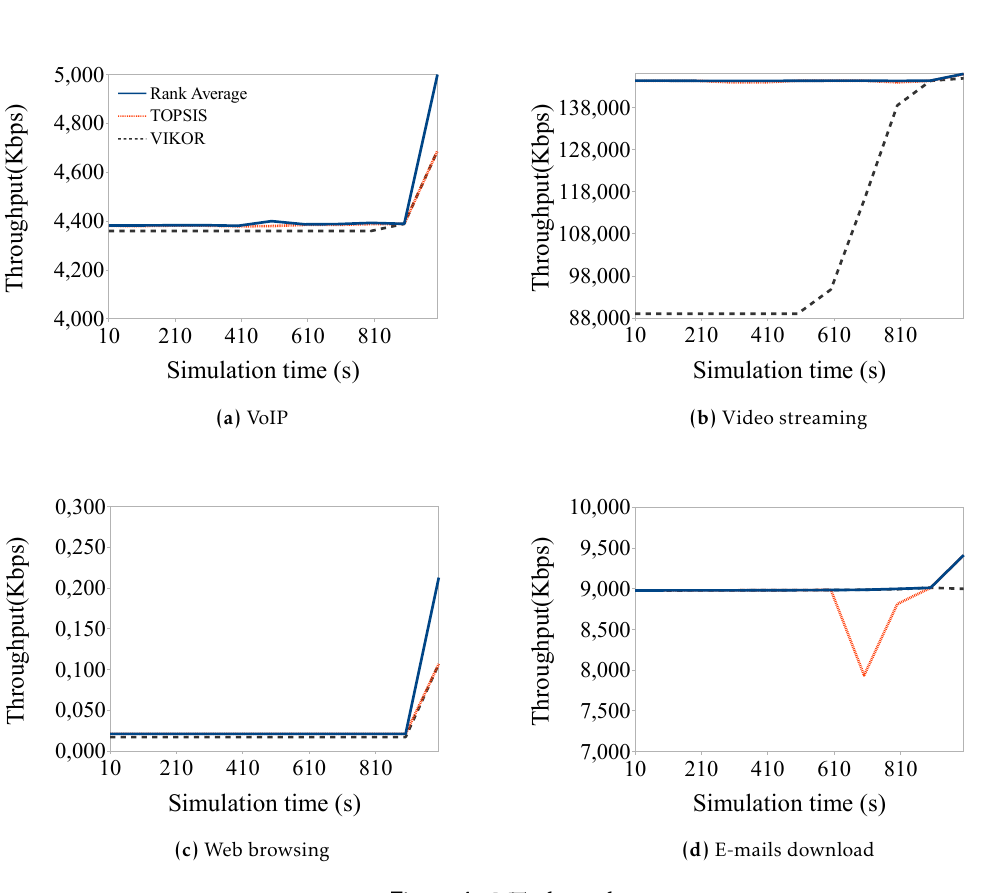
Figure 1. MTs throughput